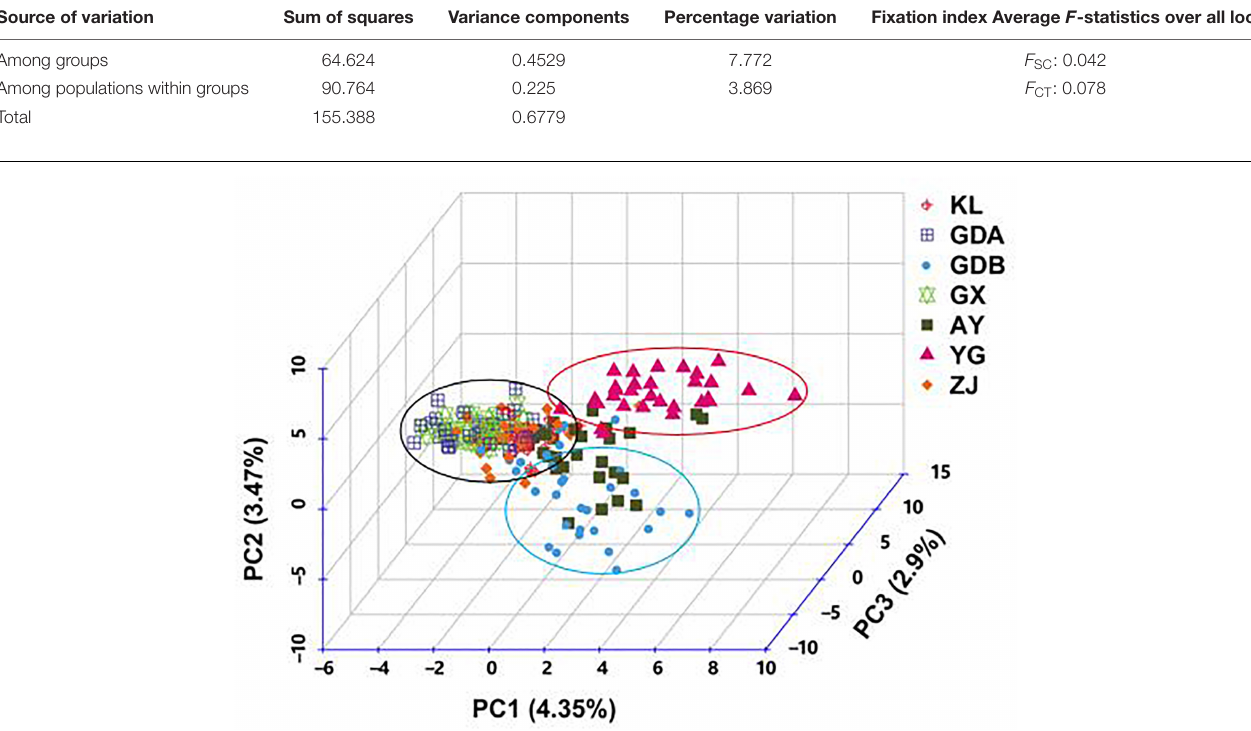
TABLE 6 | Analysis of molecular variance (AMOVA) results for seven populations of M. rosenbergii .